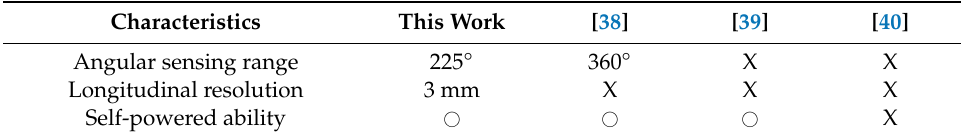
Table 3. Comparison of sensors on a curved